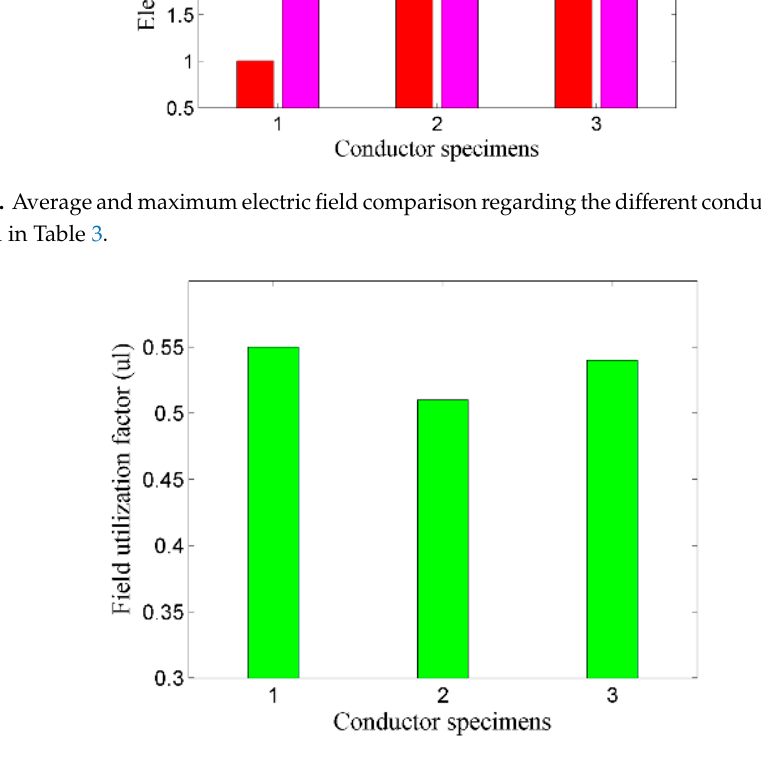
Figure 12. Field utilization factor comparison regarding the different conductor specimens described in Table 3.